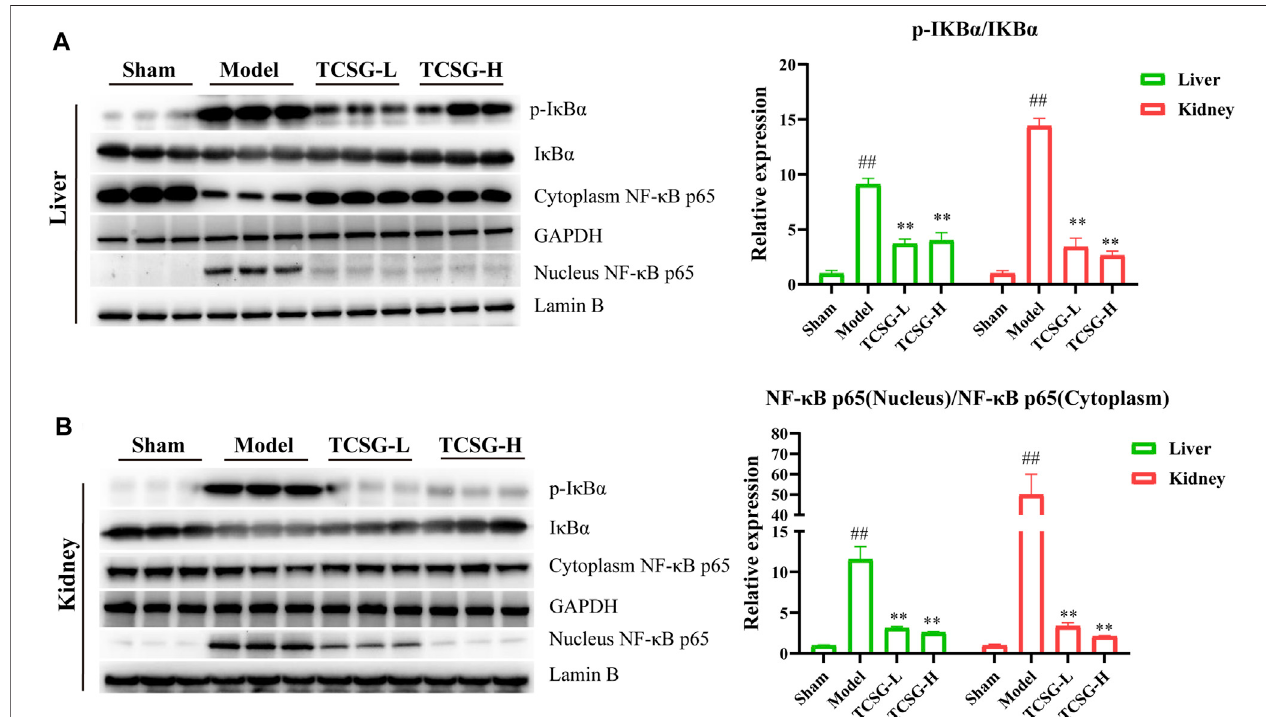
FIGURE 7 | TCSG from Baishouwu blocked the nuclear localization of NF- κ B p65 in the liver and kidney. (A) Western blot and quantitative analysis of p-I κ B α and nucleus NF- κ B p65 expression in the liver. (B) Western blot and quantitative analysis of p-I κ B α and nucleus NF- κ B p65 expression in the kidney. Data are shown as means ± SEM ( n (cid:1) 3), ## p < 0.01, signi fi cantly different from sham group; ** p < 0.01, signi fi cantly different from model